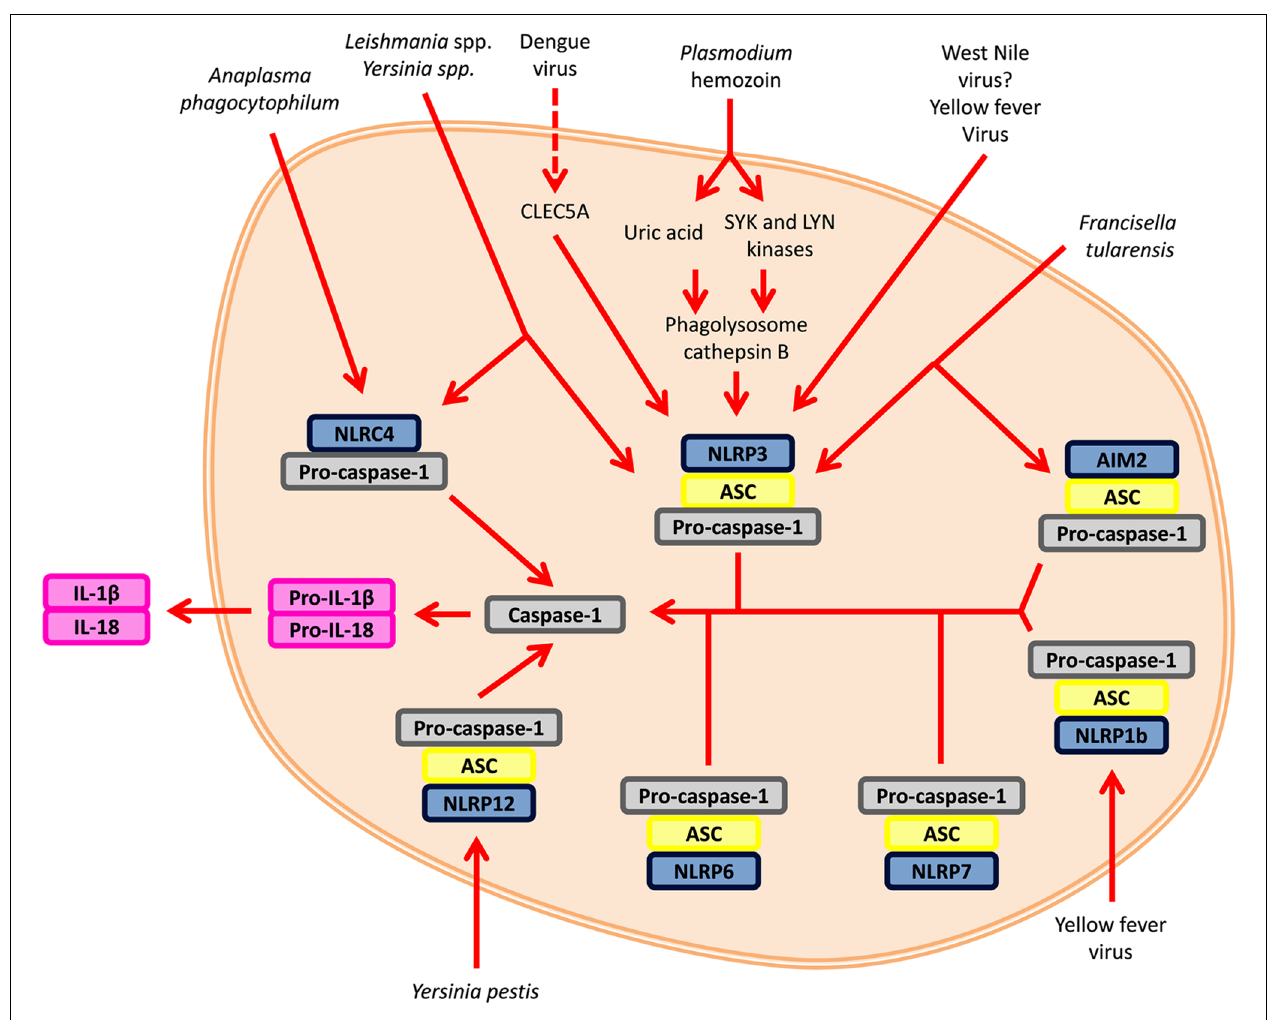
FIGURE 2 | Inflammasome signaling. The inflammasome is activated by two signals. The first signal ( not shown ) involves the recognition of an agonist/PAMP by a receptor, such as TLRs, and upregulates transcription of pro-inflammatory cytokines and key NLRs. Signal two is the initiation